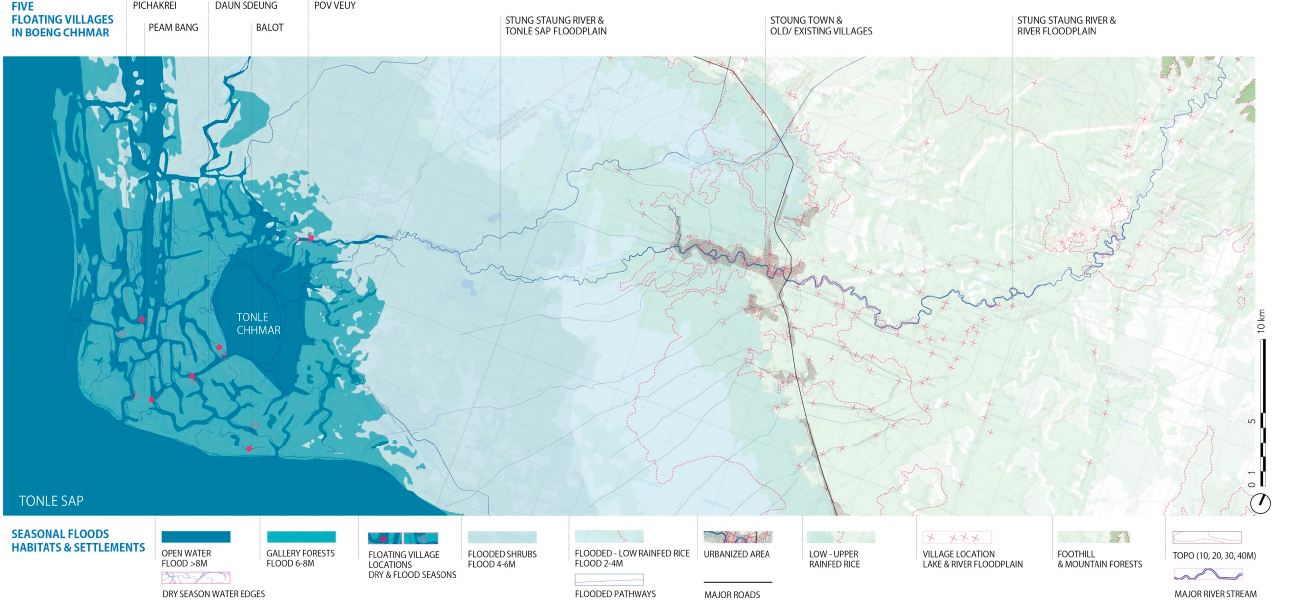
Figure 6. Territorial transect (Tonle Sap and Stung Staung river floodplain and settlements) and Boeng Chhmar’s floating villages. An overlay map of habitats, flood conditions, topography, village system, and urbanized area (Linh Vu, 2022, mapping from GIS open source, Cambodia topography, google earth, and fieldwork observations of floating village locations in dry and flooding